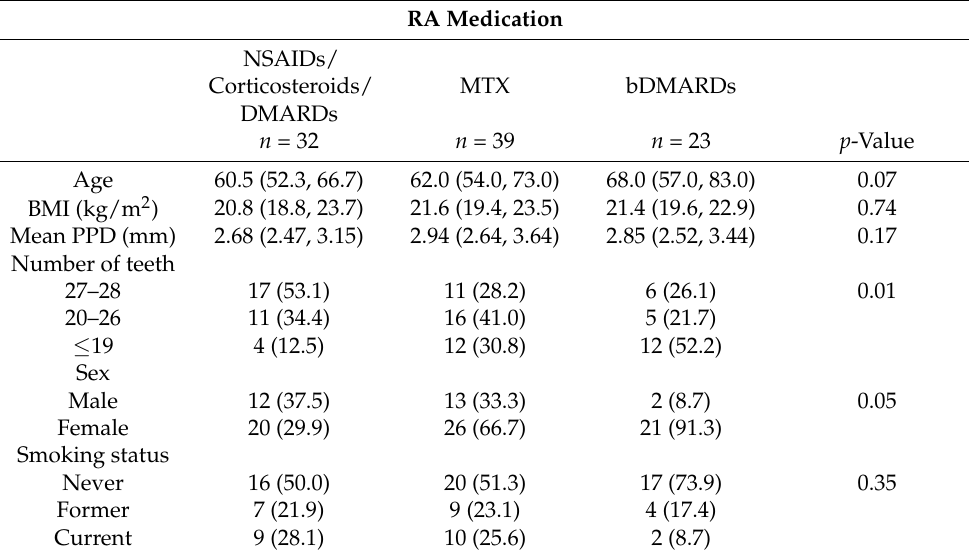
Table 3. Relationship between A medication and other variables in patients with